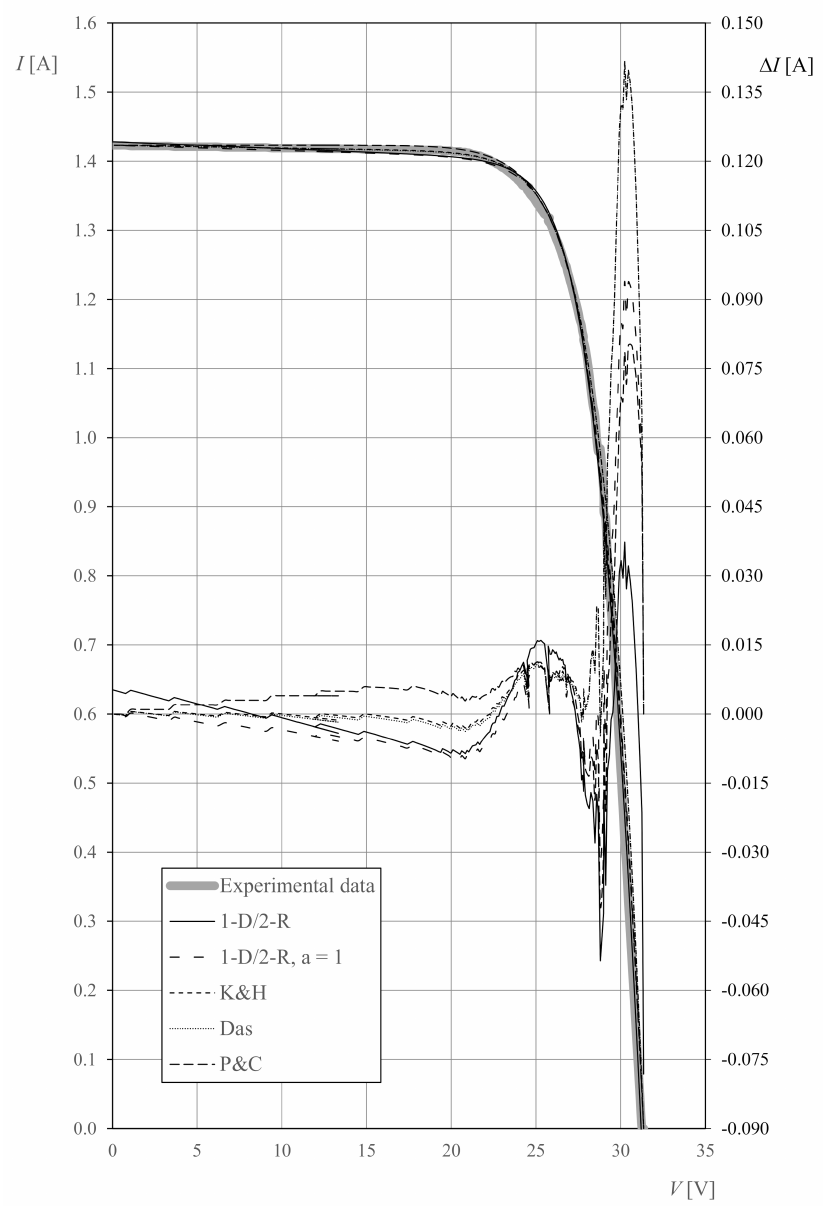
Figure 12. I-V experimental curve (left axis) for the UPM-6 solar panel. Curves for the 1-D/2-R equiv- alent circuit model (obtained using two procedures: best fit to the parameters obtained numerically and analytical extraction) and the explicit methods of Kalmarkar and Haneefa, Das and Pindado and Cubas are shown. The differences in the current compared to the experimental data are indicated on the right